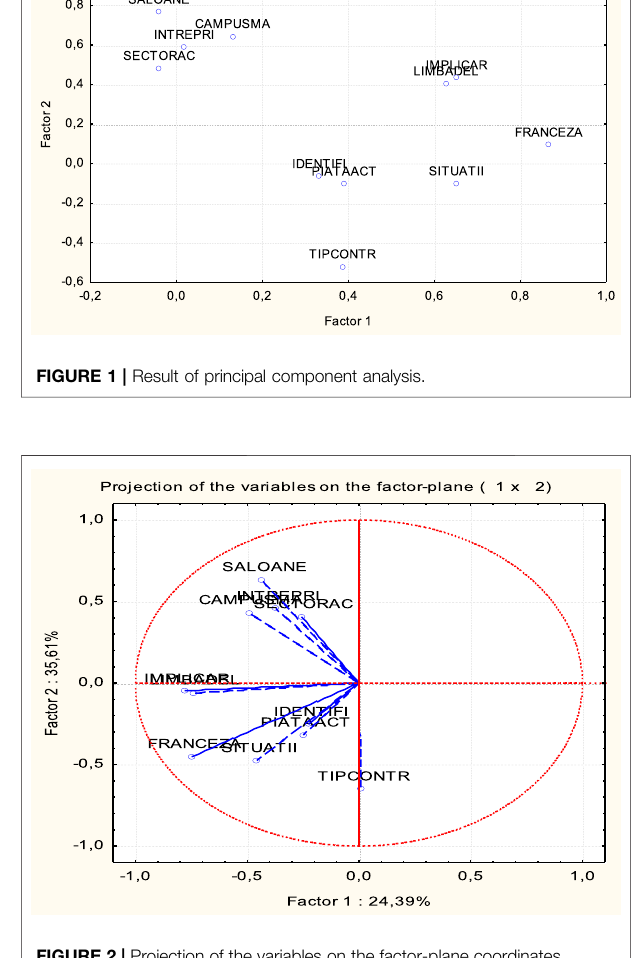
FIGURE 2 | Projection of the variables on the factor-plane coordinates and the variation explained by each factor resulted from the PCA — correlation circle.